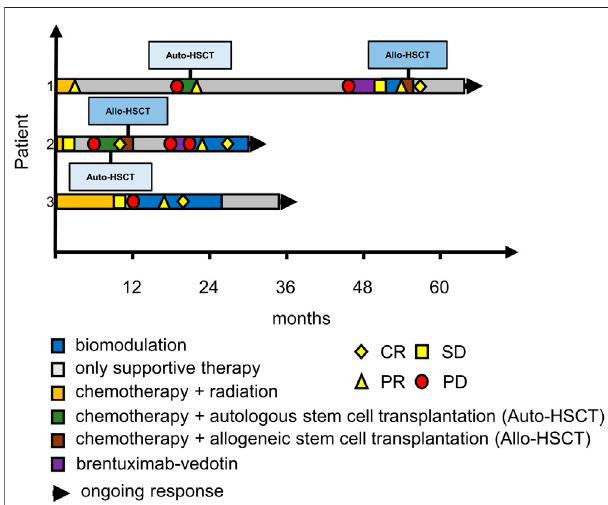
FIGURE2| Swimmerplotsofpatients1to3.Patient1hadresidualdisease with PET DS-4 after 2 months on MEPED and achieved cCR following haploidentical allo-HSCT; patient 2 achieved cCR with MEPED following relapse afterallo-HSCT,patient3remainedinCRduringconsolidationtreatmentwith MEPED and is now > 12 months in CR without any Hodgkin therapy. CR: PET negativity (DS-1 to 3) plus/minus residual tumor in CT-scans. PR: PET positivity (DS-4 to 5) plus PR according to RECIST in CT scans. SD: stable disease. PD: progressive disease. DS: PET Deauville score (1 – 5).